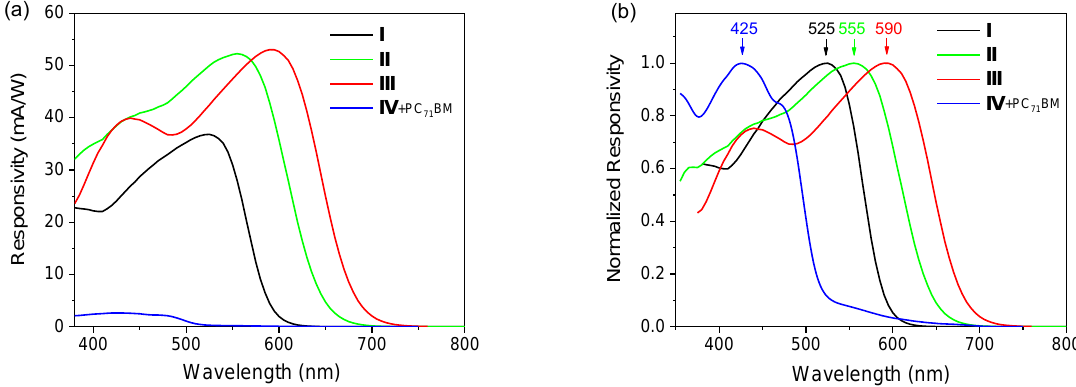
Table 1. Hole ( µ h ) and electron ( µ e ) mobilities.